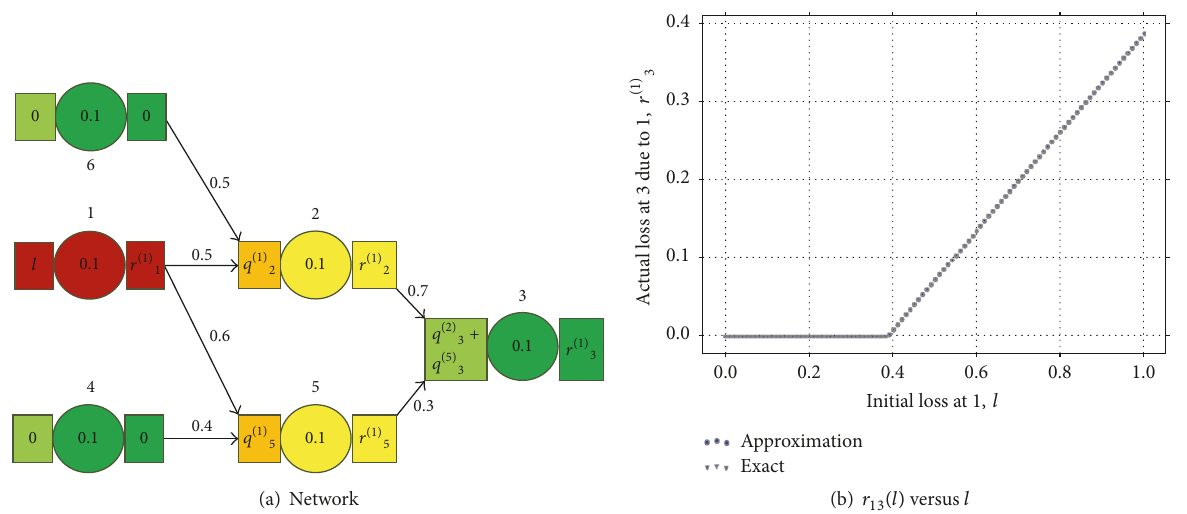
Figure 2: (a) Sample network and (b) comparisons of exact and approximate expressions for the loss sustained by node 3 due to a loss at node 1, 𝑟 13 (𝑙) , against the loss sustained by node 1, 𝑙 . The network follows the schema and variables shown as in Figure